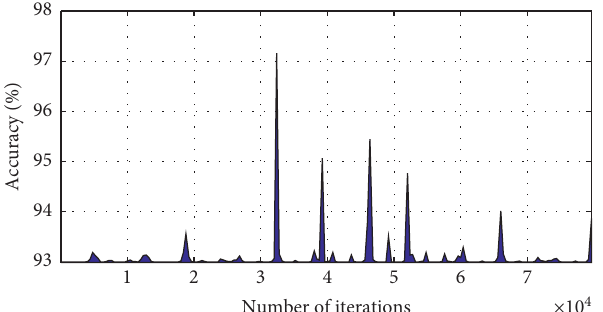
Figure 8: The relationship between training time and recognition accuracy.